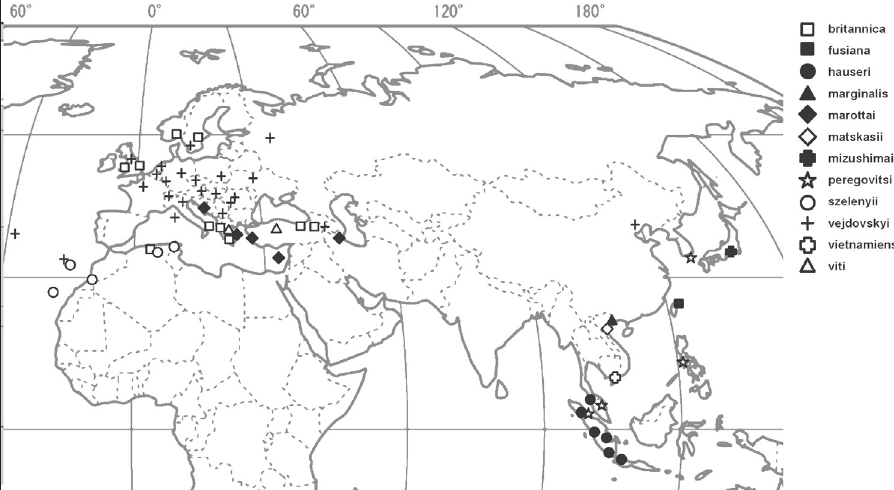
Figure 4. Distribution map of Ortheziola